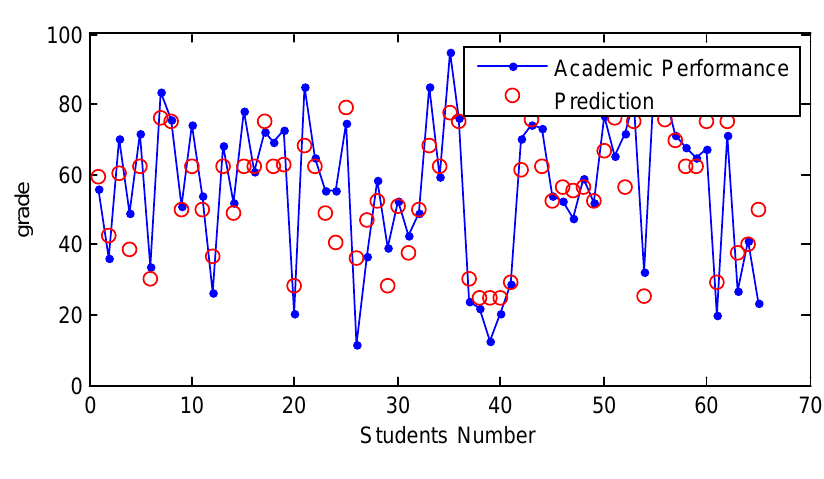
Graph 4. Comparison graph for test data.